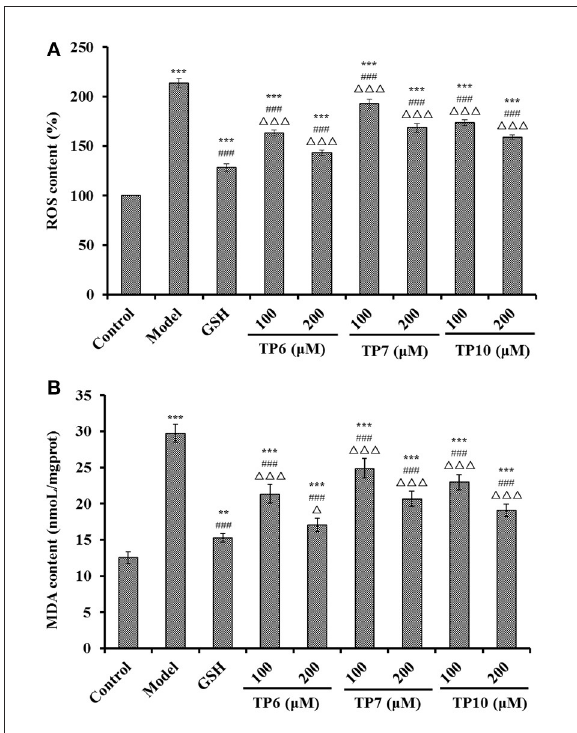
FIGURE10 Effects of TP6, TP7, and TP10 on the ROS (A) and MDA (B) levels of H 2 O 2 -damaged HUVECs. *** P < 0.001 and ** P < 0.01 vs. control; ### P < 0.001 vs. model; 1 P < 0.05 and 111 P < 0.001 vs. GSH.